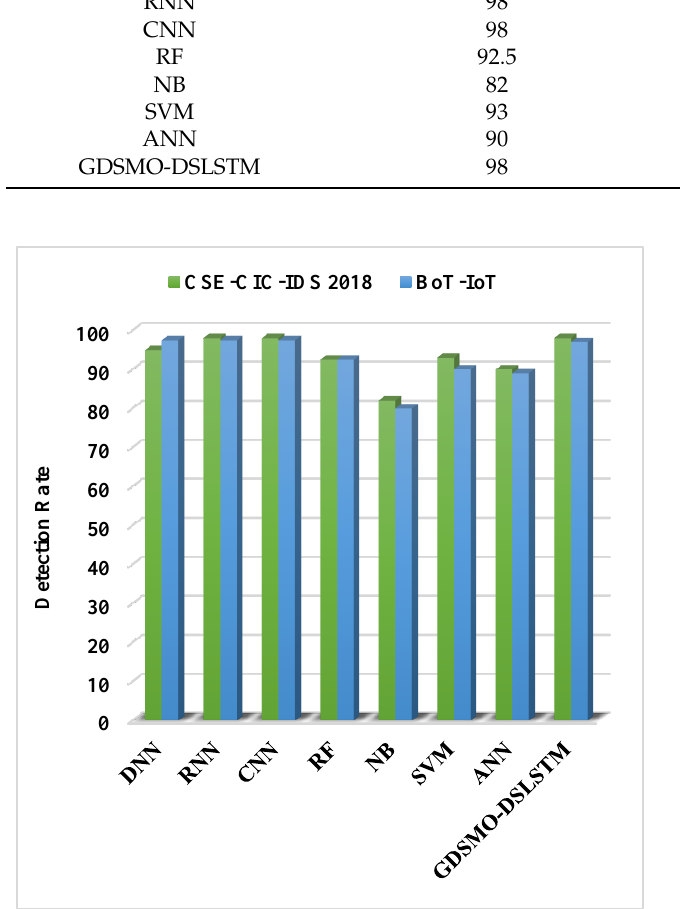
Figure 20. Detection rate of existing and proposed deep learning mechanisms for both the CSE-CIC-